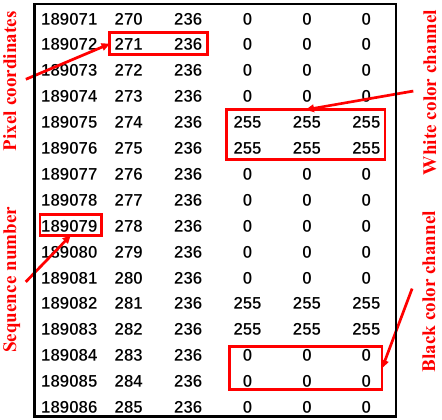
Figure 5. Pixel coordinate extraction diagram.